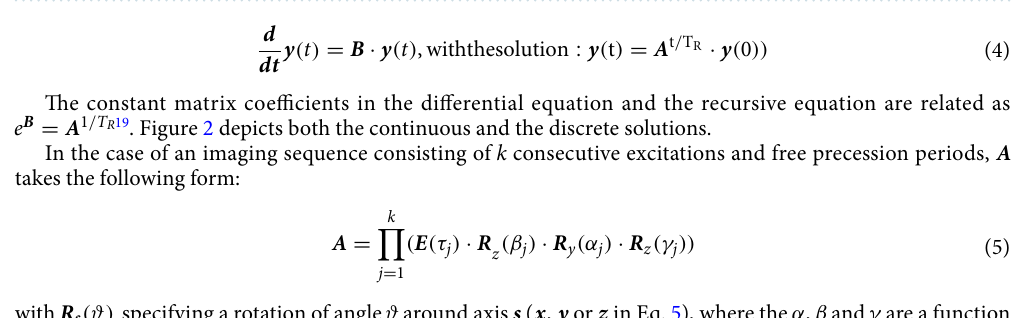
Figure 2. ( a–c) The repeated block consists of an excitation with flip angle α =30º, β =14º (accumulated phase as a result of off-resonance during T R , T R =10 ms), relaxation times are T 1 = 878 ms, T 2 = 47.5 ms. n 1 and n 2 span the plane of oscillation. The magnetization vector always points to a point of this plane. Only the orientation of the plane is fixed throughout the evolution; it shifts parallel to n 3 . Figure (a) 3D trajectory, (b) x–y projection (transversal plane), (c) x and y component (signals measured in quadrature). Figures (d–f) similar to (a–c) with on-resonance ( β =0º). The plane spanned b. n 1 and n 2 is the x–z plane throughout the entire evolution. The points represent the magnetization difference vector and its evolution along the sequence. The continuous line is the corresponding continuously parametrized y ( τ ) = A τ / T R µ 0 . The quantity y ( τ ) satisfies the differential equation: d ( t ) = B · y ( t ) with exp ( B ) = A 1 / T R . y ( τ ) is not the fully continuous trajectory of the magnetization µ . dt y However, y ( τ ) and µ are equal at the discrete time points: y ( τ = nT R ) = µ n